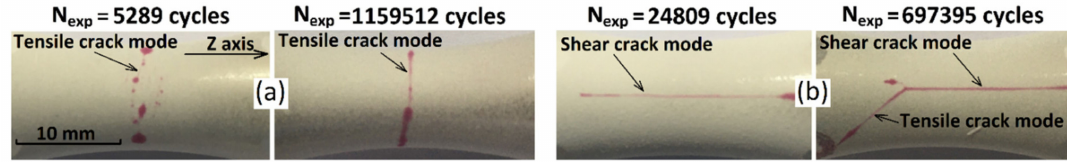
Figure 7. Exemplary photos of fatigue cracks under cyclic ( a ) bending and ( b ) torsion loads for the 7075-T651 aluminium